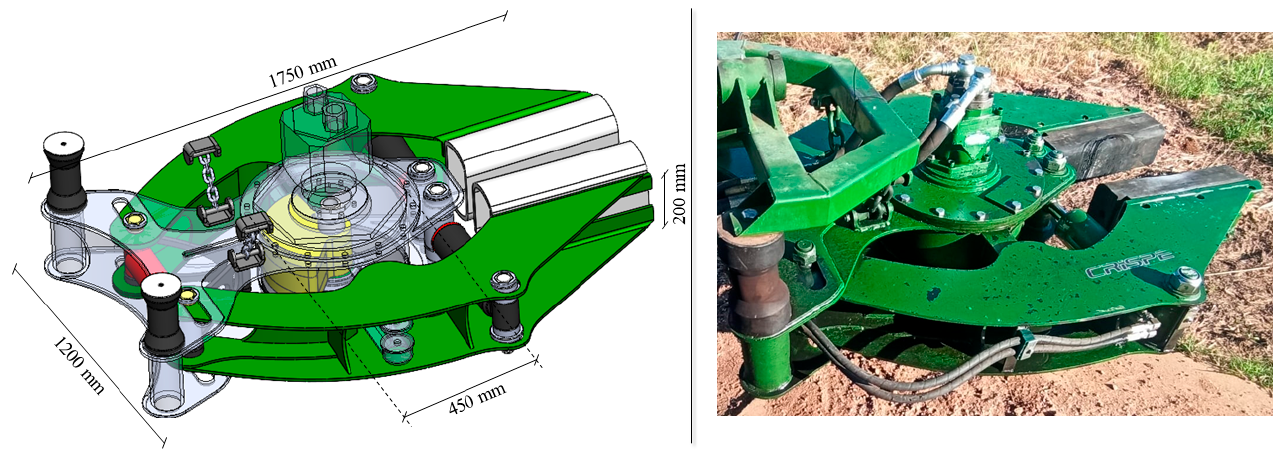
Figure 1. Trunk shaker designed ( left ) and fabricated and mounted on the tractor ( right ).